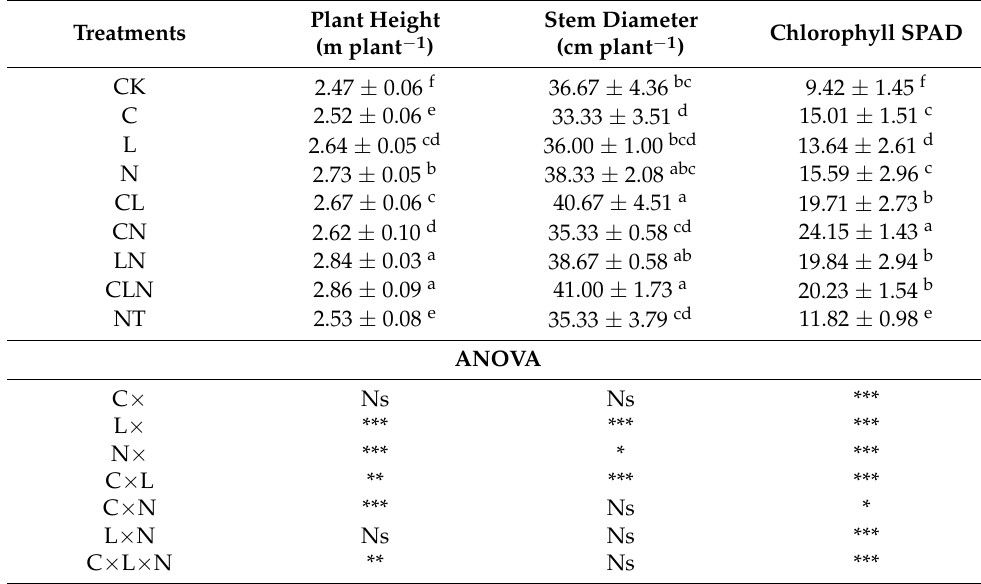
Table 4. Growth analysis of stem and leaf in the fruiting stage in papaya.